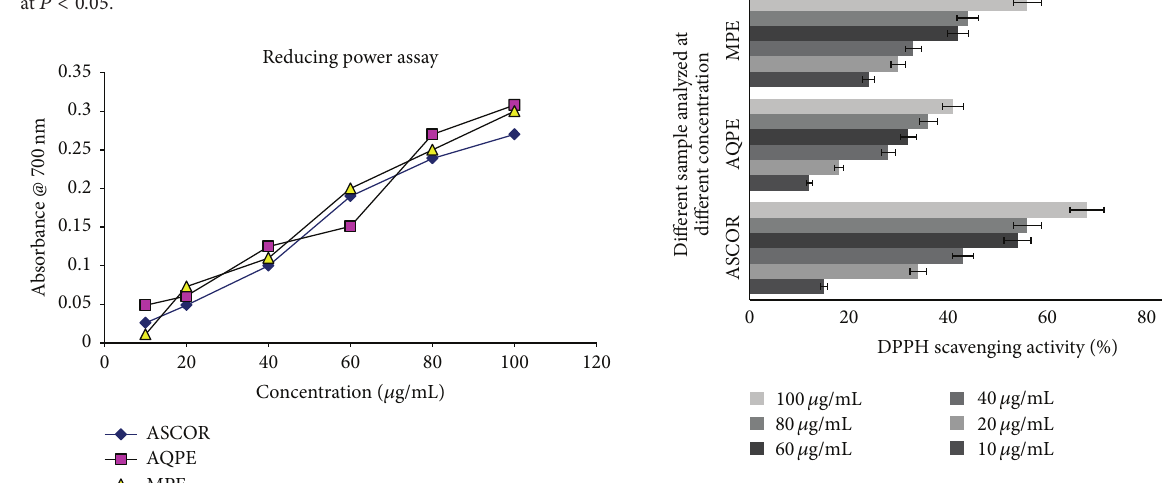
Figure 3: Dose inhibition curve of the aqueous and methanolic extract of P. granatum peel on DPPH scavenging activity. Values are means ± SE of analyses done in triplicate. ∗ Concentration of hydrolyzed extracts in increasing order: 10, 20, 40, 60, 80 and 100 𝜇 g/mL;concentrationofascorbicacidinincreasingorder:0.005, 0.01, 0.02, and 0.03 𝜇